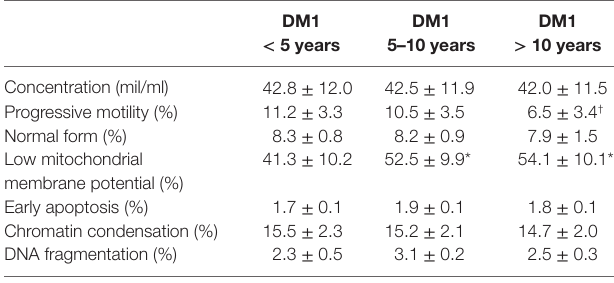
Table 2 | Conventional and biofunctional sperm parameters in patients with type 1 diabetes mellitus (DM1) according to the duration of the disease.